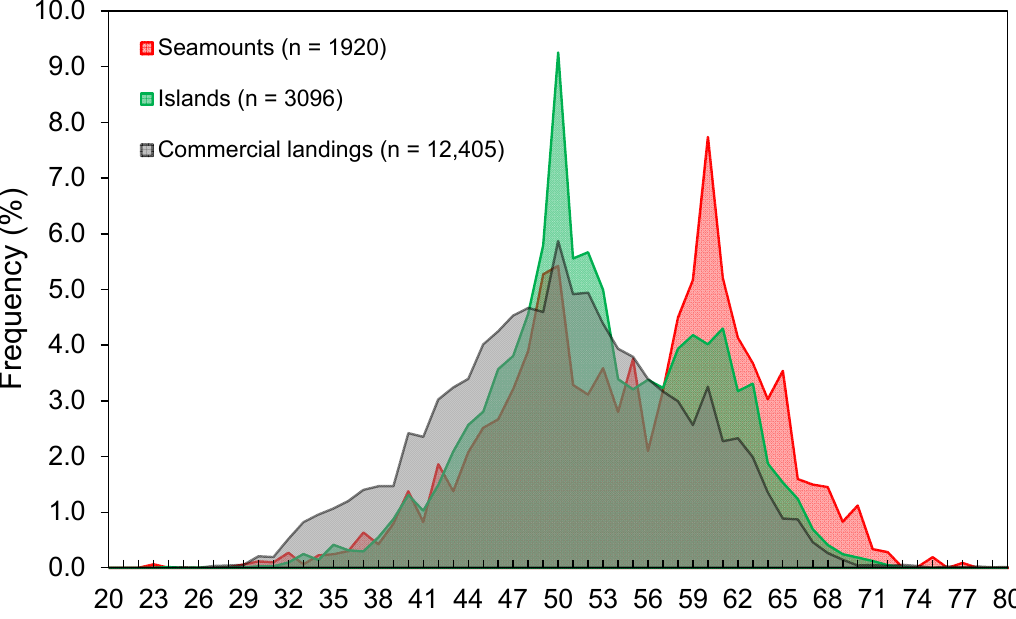
Figure 3. Fork length ( L F )–frequency distribution of Mora moro derived from the surveys (1996–2019) and commercial landings (1990–2017) in the Azores. Data from surveys are shown by area (seamounts and islands) and the total number of individuals (n) refers to the total RPN (ind. 10 − 3 hooks).